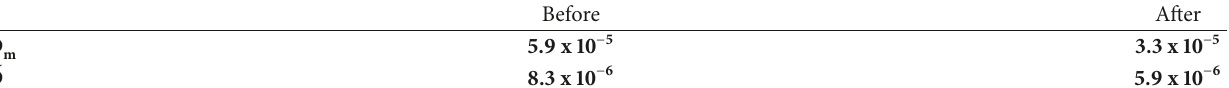
Table 5: Diffusion coefficient of mobility and water vapor (cm 2 /s) in Z5A-2 before and after CO 2 adsorption at 373 K.